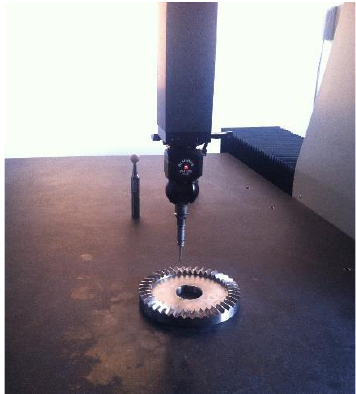
Figure 14. Face-gear tooth-surface detection.